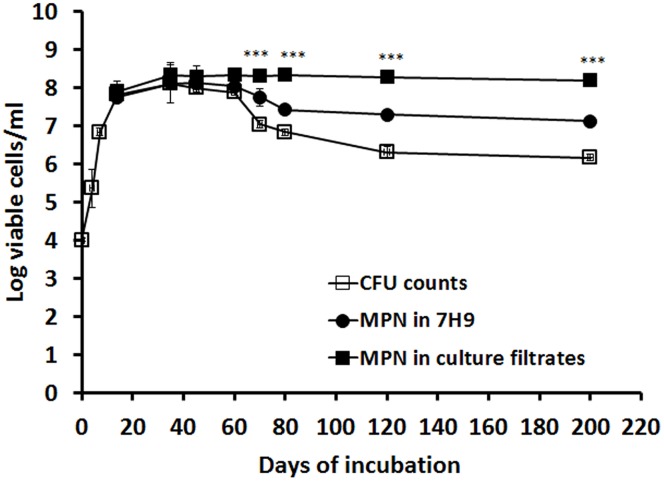
Resuscitation of RPF-dependent tubercle bacilli from the in vitro hypoxic model of M. tuberculosis.
M. tuberculosis H37Rv was grown in 7H9 medium without disturbance for 200 days. CFU counts were performed at different time points in triplicate (line with empty squares). MPN counts from cultures of 14, 35, 45, 60, 70, 80, 120, and 200 days were performed with 7H9 medium (line with solid circles) or the culture filtrate (line with solid squares). These experiments were performed three times with reproducible results. ANOVA analysis demonstrated that there were significant differences amongst CFU counts, 7H9 broth counts and RPF broth counts (∗∗∗P < 0.001 to 0.0001).